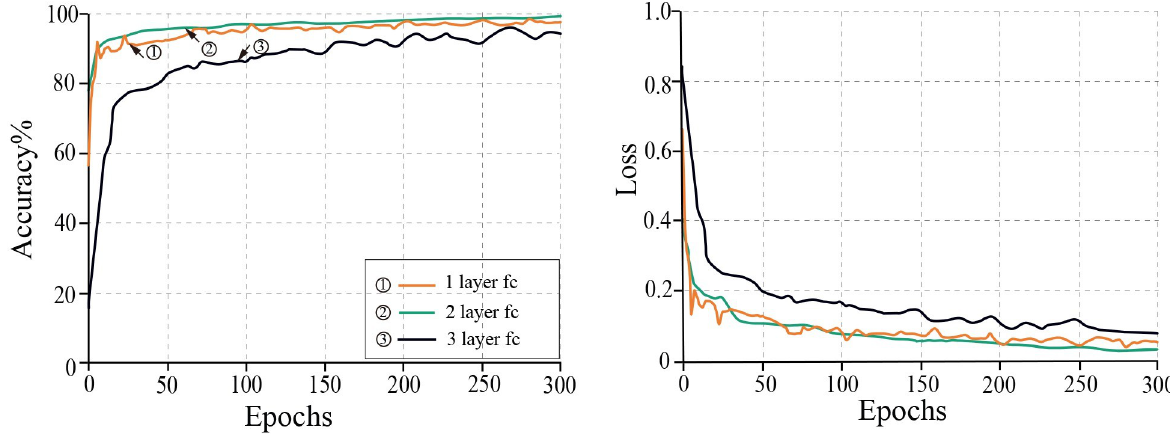
Fig 10. Effects of fully connected layers on training accuracy and training loss.